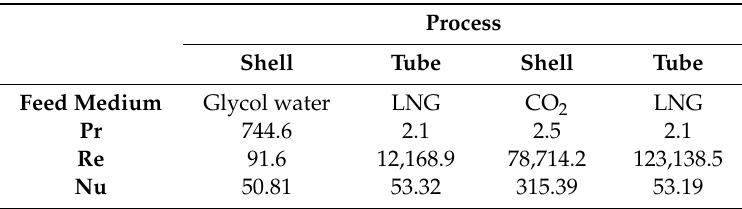
Table 2. LNG heat exchanger overall coe ffi cients of heat transfer at optimal conditions. Pr: Prandtl number; Re: Reynolds number.